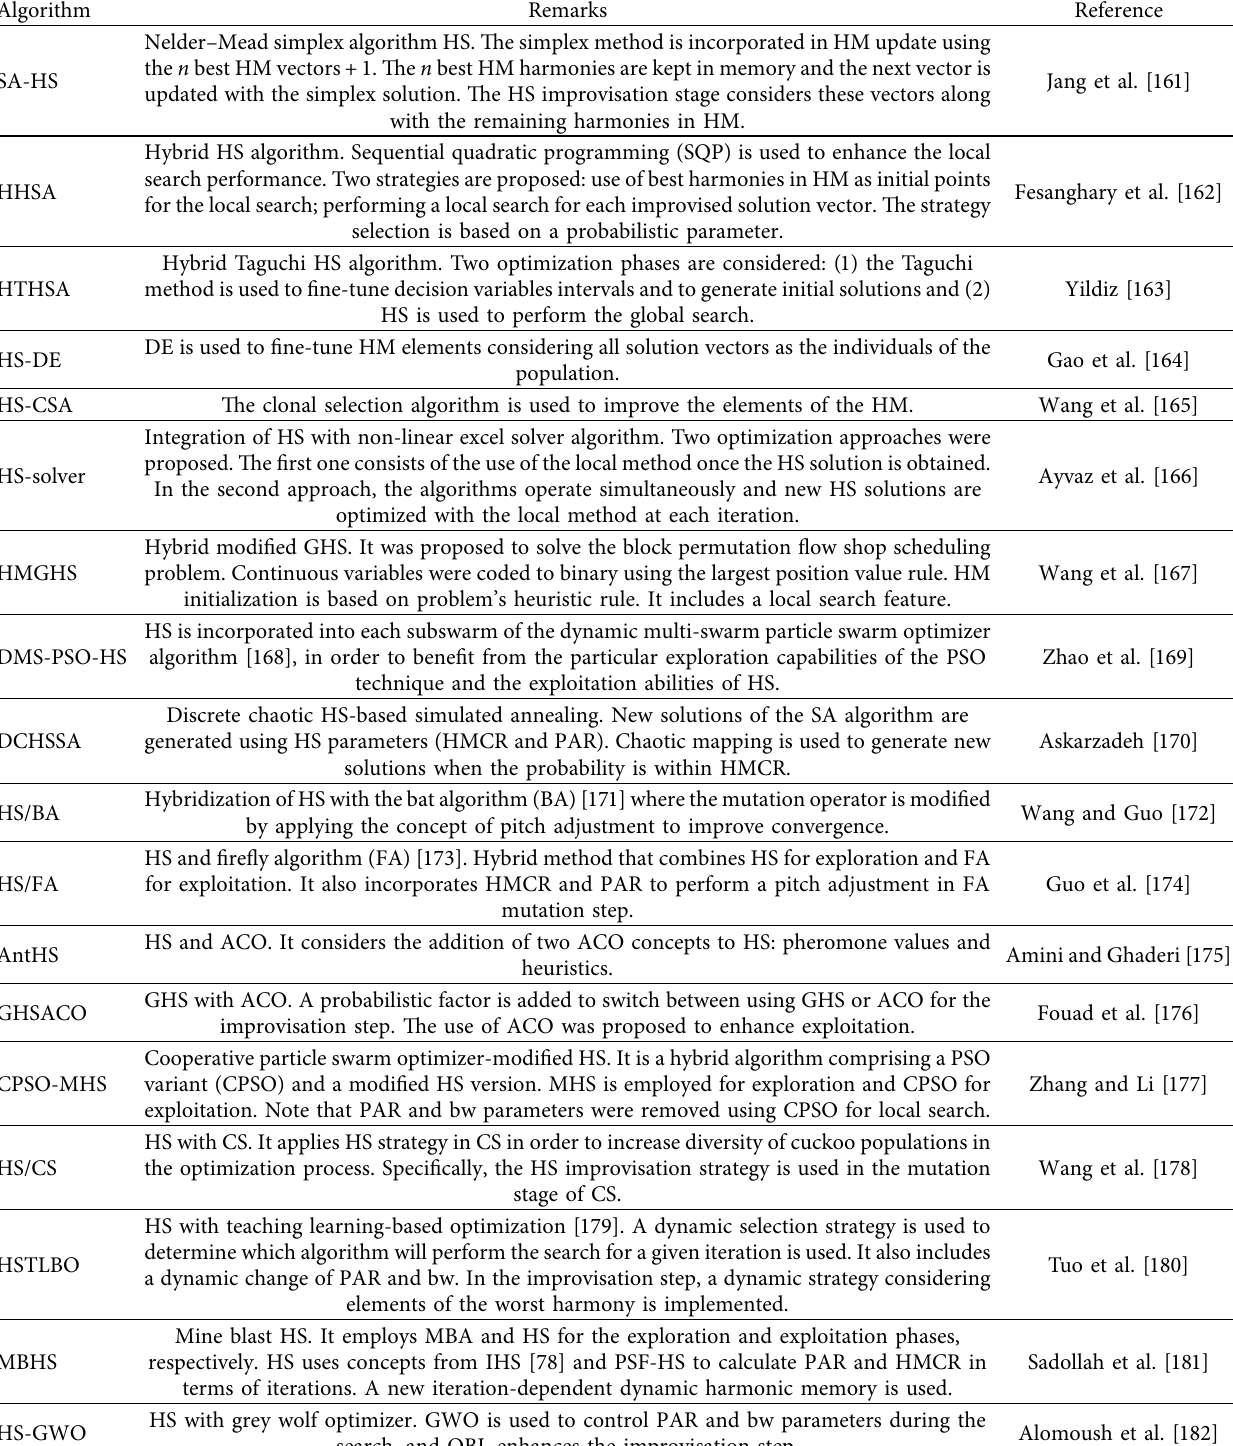
Table 5: Harmony search variants based on hybridization with other